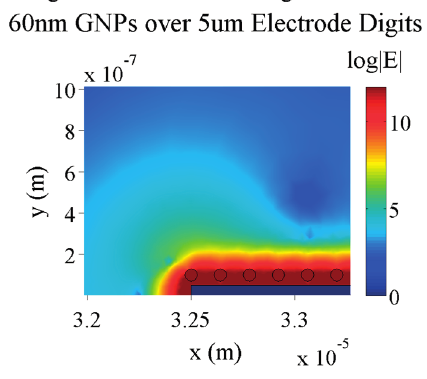
Figure 5. Electric field magnitude of a 5 µm gold electrode with 60 nm GNPs placed 20 nm above the electrode surface after 0.1 s to completely establish electric screening. A voltage of 0.1 V is applied to the electrode here and the field is in the presence of a 150 µM KCl buffer